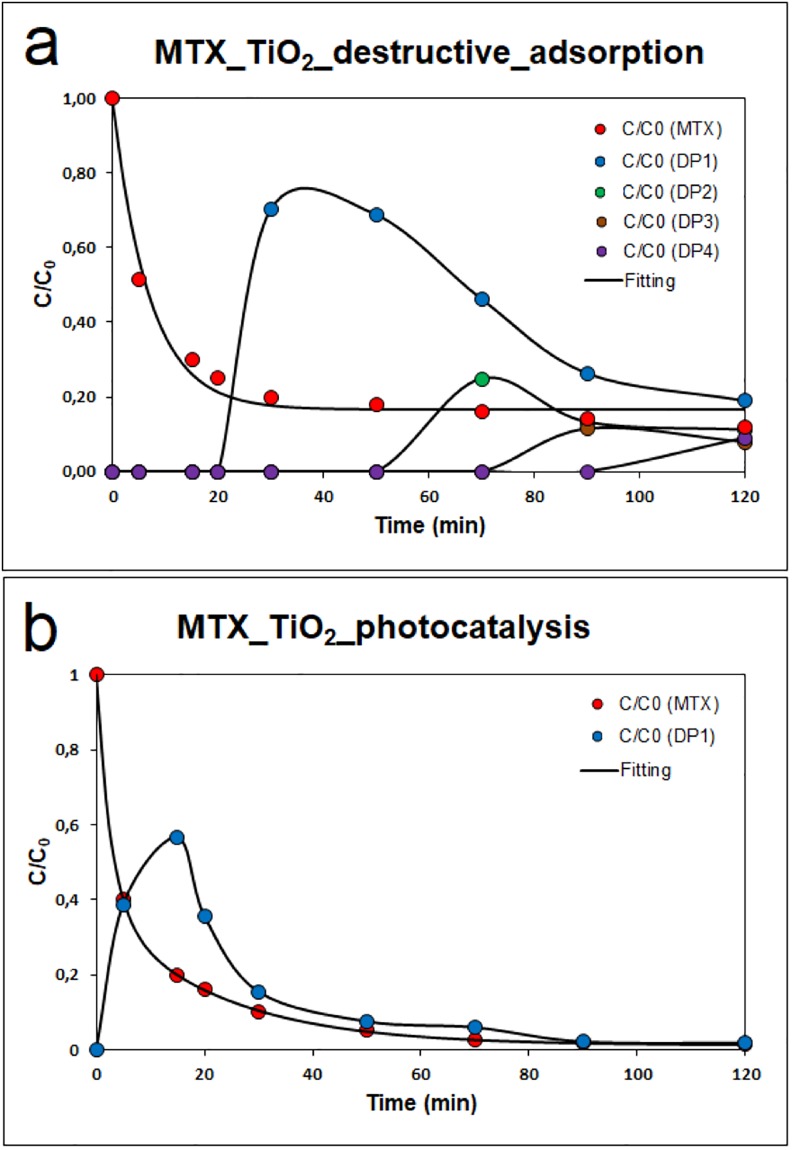
Kinetics of mitoxantrone degradation in the presence of TiO2 a) sorption and b) photocatalysis.